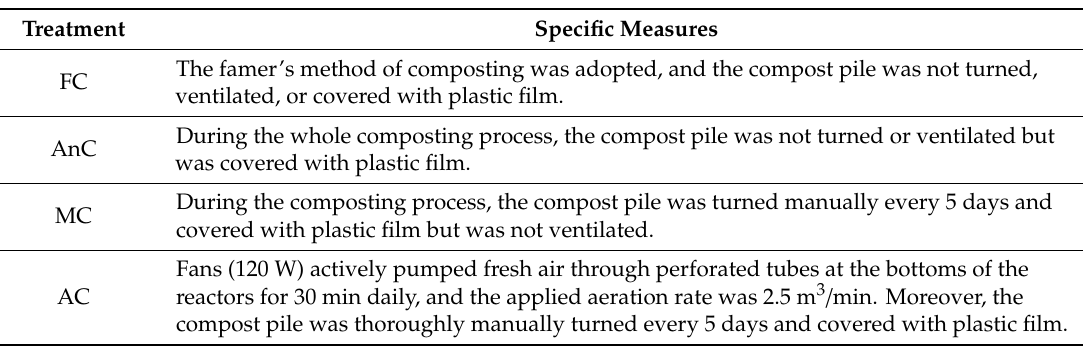
Table 1. Experimental